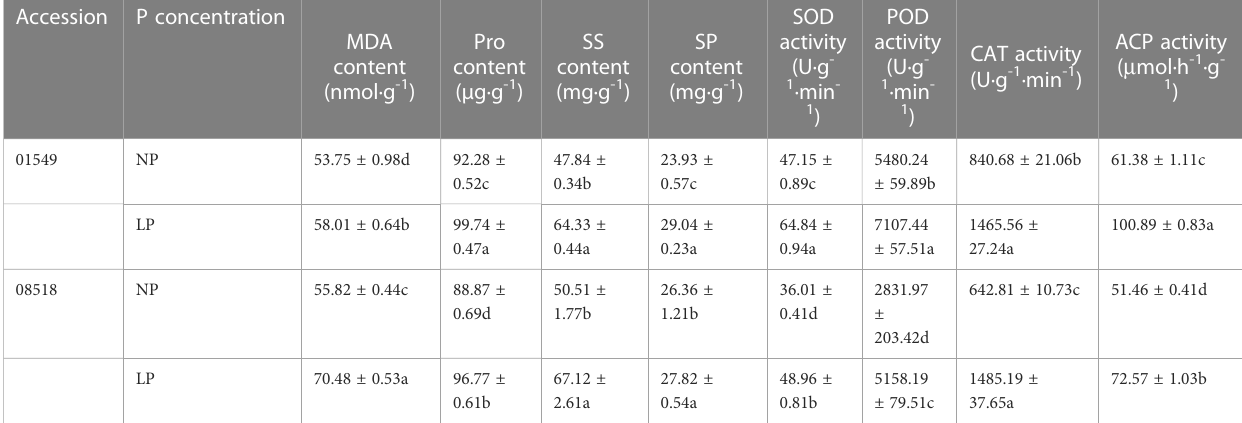
TABLE 3 Effect of low-P stress on the root physiological traits of L. corniculatus lines 01549 and